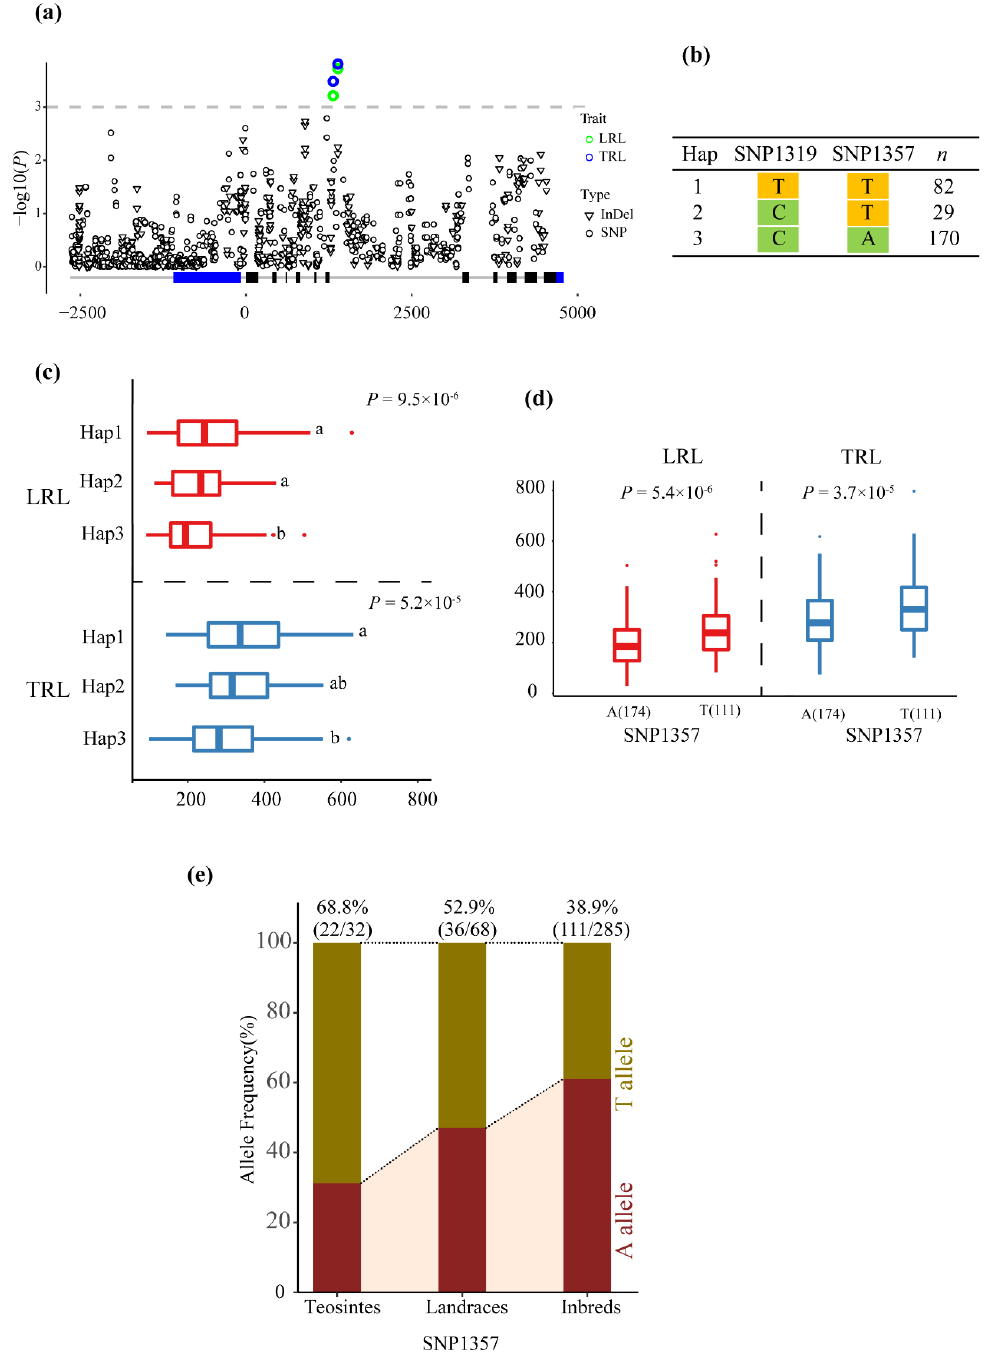
Figure 4. Natural variations in ZmMADS60 were significantly associated with total root length (TRL) and lateral root length (LRL). ( a ) ZmMADS60 -based association mapping for TRL and LRL, a schematic diagram of the genomic region of ZmMADS60 , including upstream sequence and introns ( light gray ), the coding region ( black ), and 5'UTR and 3 ’ UTR ( blue ) is presented. ( b ) Haplotypes of ZmMADS60 among natural variations in inbred lines. ( c ) Phenotypic difference between different haplotypes of ZmMADS60 in inbred lines. ( d ) Comparison of TRL and LRL between different alleles of SNP1357. ( e ) The allele frequency of SNP1357 in teosinte, landrace, and inbred lines.